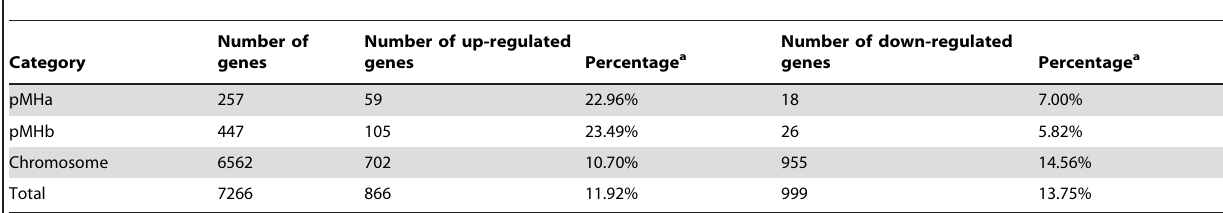
Table 1. The proportions of differentially expressed genes in plasmid and chromosome of M. huakuii 7653R during symbiosis.